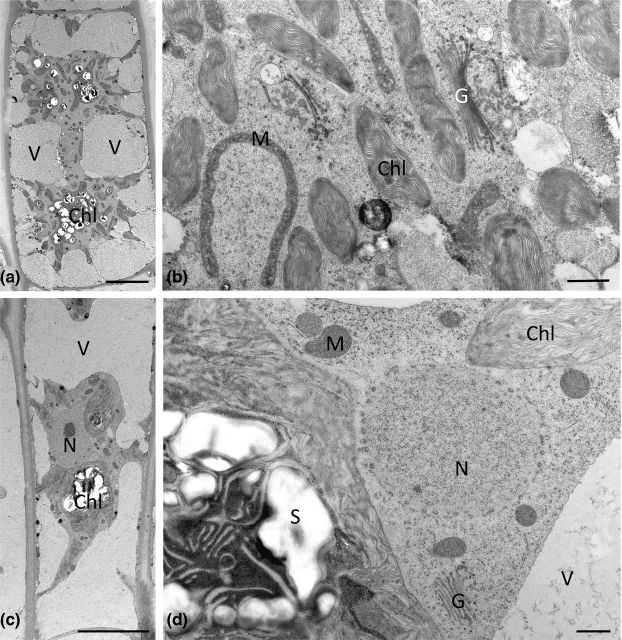
Transmission electron micrographs of young vegetative Zygnema sp. cells of strains B (a, b) and C (c, d). (a) Overview showing a high degree of vacuolization and two stellate chloroplasts, (b) cytoplasmic detail with numerous chloroplast lobes, Golgi bodies and mitochondrion, (c) overview with central nucleus and large vacuoles, (d) detail of the cell center with nucleus, Golgi body, mitochondria, chloroplast with starch grains surrounding the pyrenoid. Abbreviations: Chl chloroplast, G Golgi body, M mitochondrion, N nucleus, S starch, V vacuole. Bars: a, c 10 μm; b, d 1 μm.